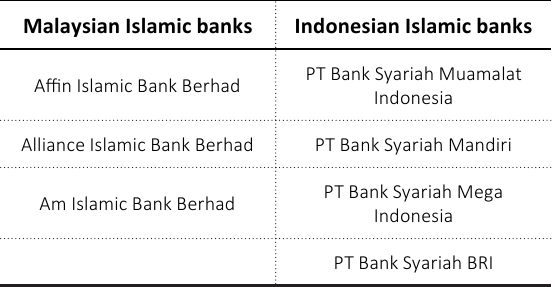
Table 2. The sample of Indonesian and